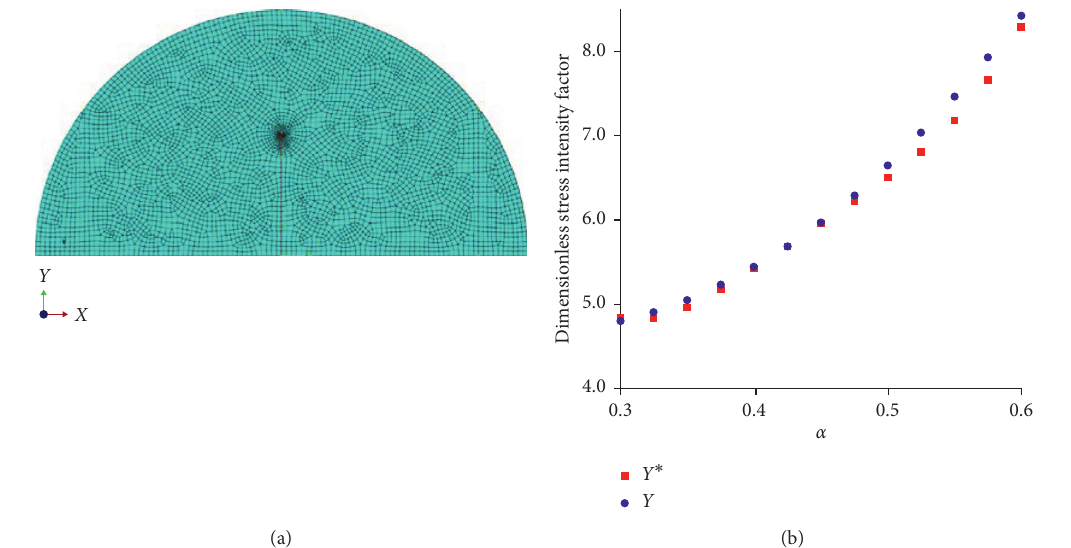
Figure 4: (a) The model of the SCB specimen in ABAQUS; (b) the values of Y ∗ and Y .